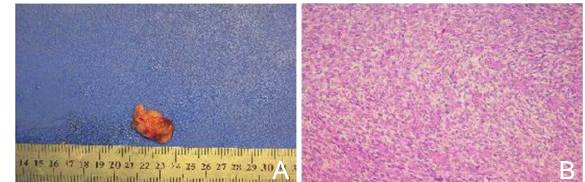
Figure 6 Intraoperative fast frozen pathology. (A) The tissue of the mass with capsule. (B) Histological examination showed verified CCSK (dyeing: HE ×10).